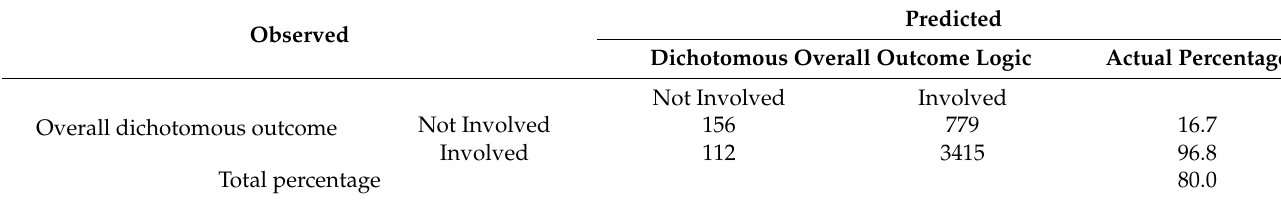
Table 11. Classification